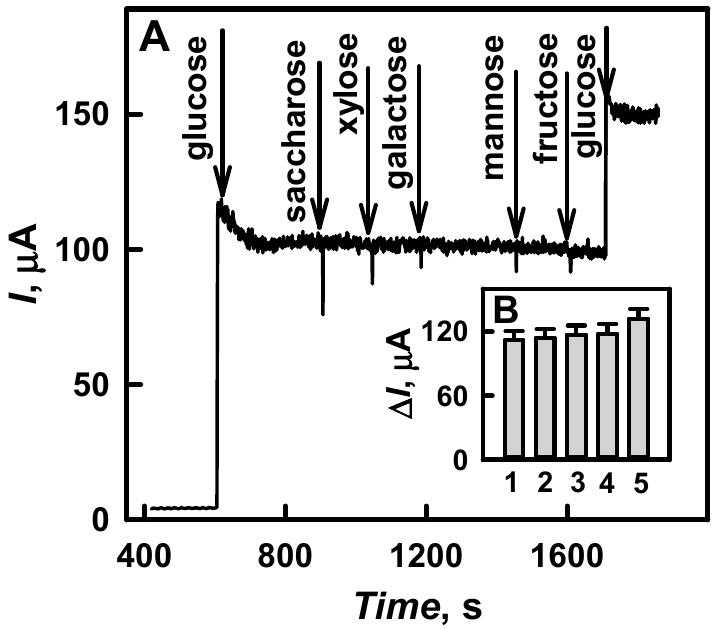
Figure 9. The effect of interfering substances on the amperometric response of the developed glucose biosensor. ( A )—Amperogram registered in 10 times diluted human serum sample after an addition of the 10.0 mmol L − 1 glucose, 1.0 mmol L − 1 saccharose, xylose, galactose, mannose or fructose. ( B )—Diagram of registered currents in 10 times diluted human serum after an addition of 10.0 mmol L − 1 glucose (column 1); 10.0 mmol L − 1 glucose with 0.01 mmol L − 1 ascorbic acid (column 2); 10.0